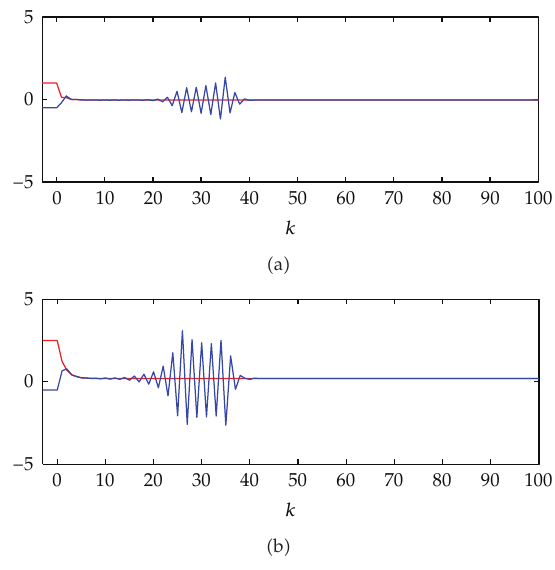
Figure 3: State trajectories of x (cid:2) k (cid:3) , (cid:4) x (cid:2) k (cid:3)